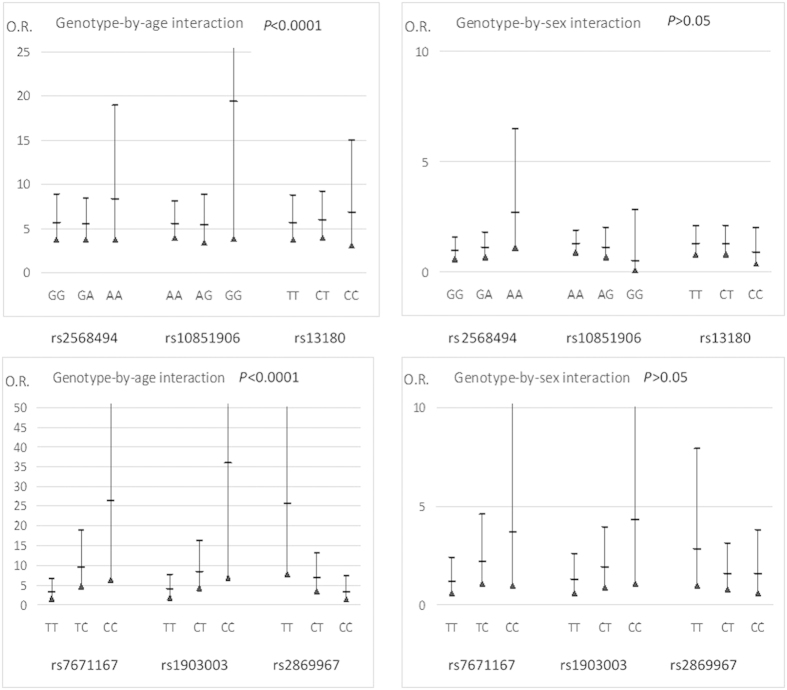
Significant influences of IREB2 and FAM13A SNPs on COPD and lung cancer according to age and sex.A multiple linear regression analysis was performed for IREB2 (rs2568494, rs10851906, rs13180) genotypes in LC and FAM13A (rs7671167, rs1903003, rs2869967) genotypes in COPD. The odds ratios with 95% confidence intervals (O.R. with 95%CI) for genotypes of selected SNPs are displayed. Control group was set as reference group. All results for age variable were statistically significant. LC: lung cancer; COPD: chronic obstructive pulmonary disease.